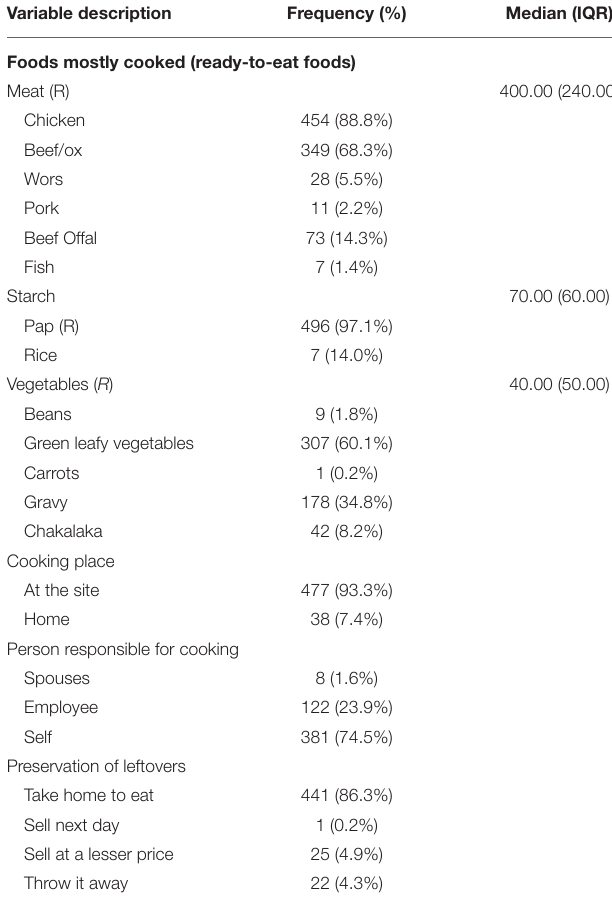
TABLE 3 | Employment status and operational hours of street food vendors. TABLE 4 | Inputs and inputs supplier profiling.